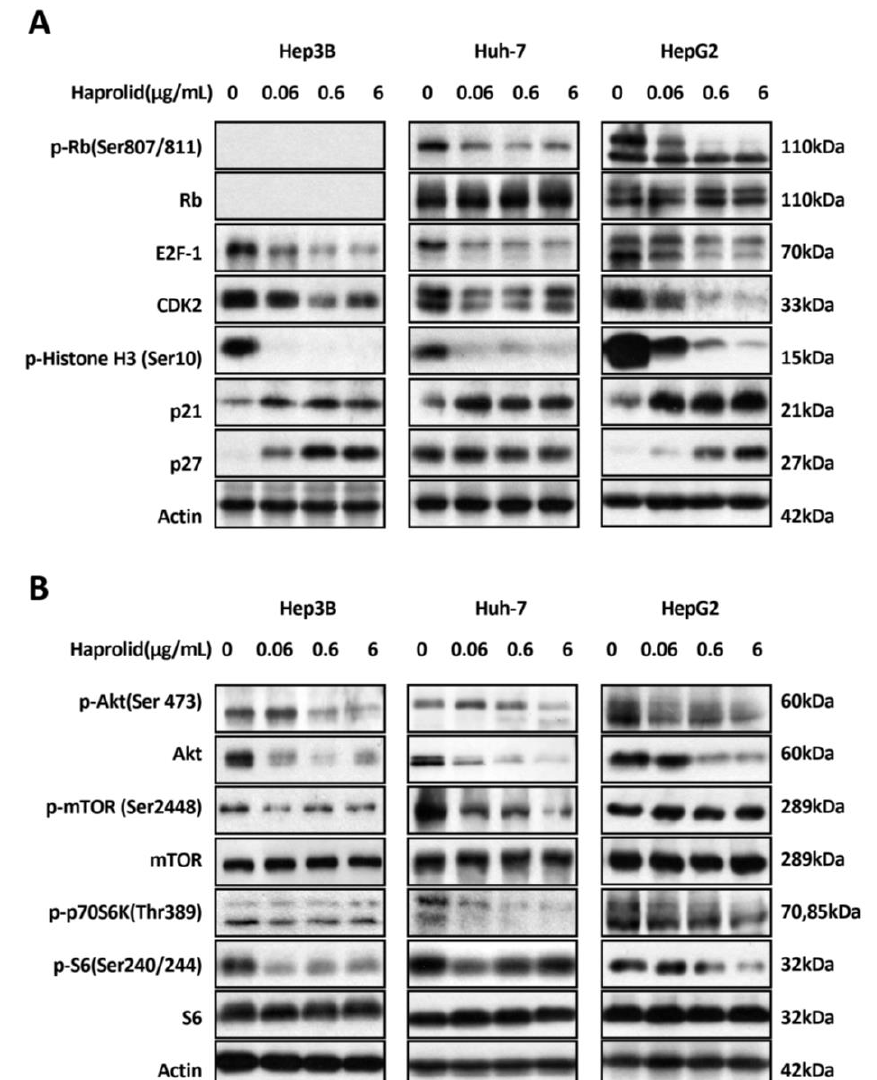
Figure 6. Dual inhibition of Rb/E2F and Akt/mTOR pathways by haprolid. ( A and B ) Hep3B, Huh-7 and HepG2 cells were treated with increasing concentrations of haprolid or DMSO for 96 h. Cell lysates were analyzed by Western blotting with antibodies against indicated proteins. β-actin is shown as a loading control. Images representative of at least three independent experiments are shown.